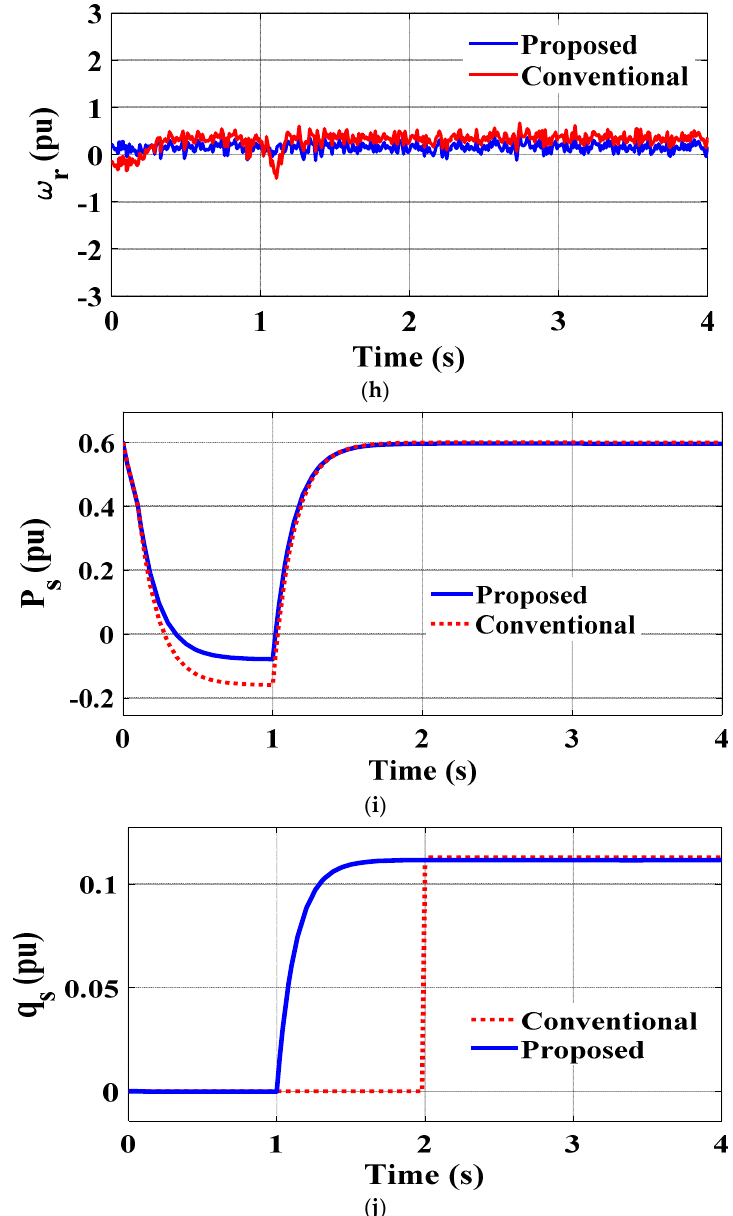
Figure 6. ( a ) Stator voltage response; ( b ) stator voltage phase A response; ( c ) stator current response; ( d ) stator current phase A response; ( e ) stator flux response; ( f ) stator flux phasor modeling during three-phase symmetrical fault response; ( g ) positive and negative sequence of the stator for phase A–G response; ( h ) angular rotor speed response; ( i ) real power response; ( j ) reative power response.